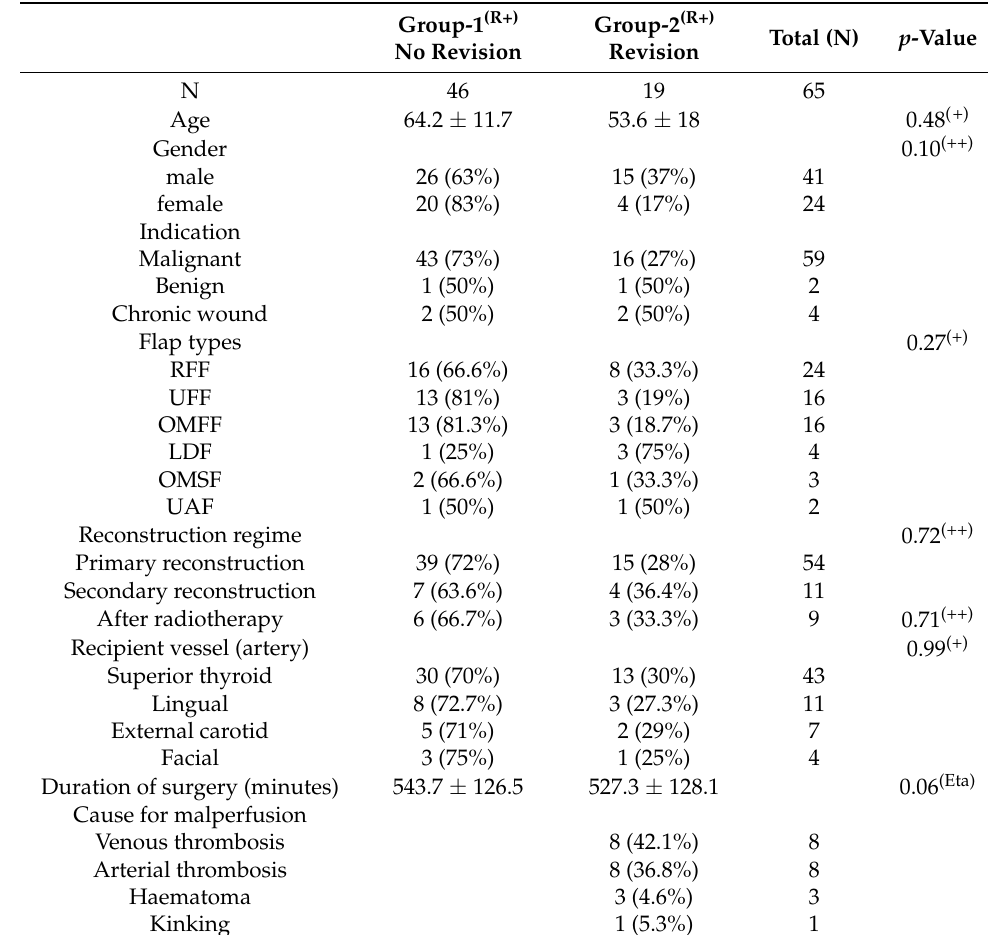
Table 2. Baseline data showing patient and flap